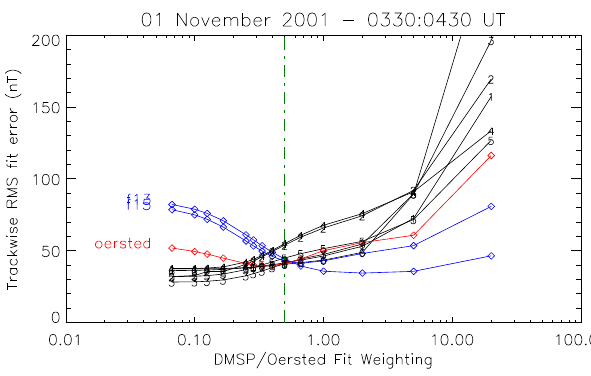
Fig. 1. Trackwise plot of the azimuthal fit error for all six Iridium tracks (black), two DMSP satellites (blue) and the Oersted satellite (red) as a function of the DMSP and Oersted data weighting factor. The green vertical line indicates the chosen weighting factor for this event.